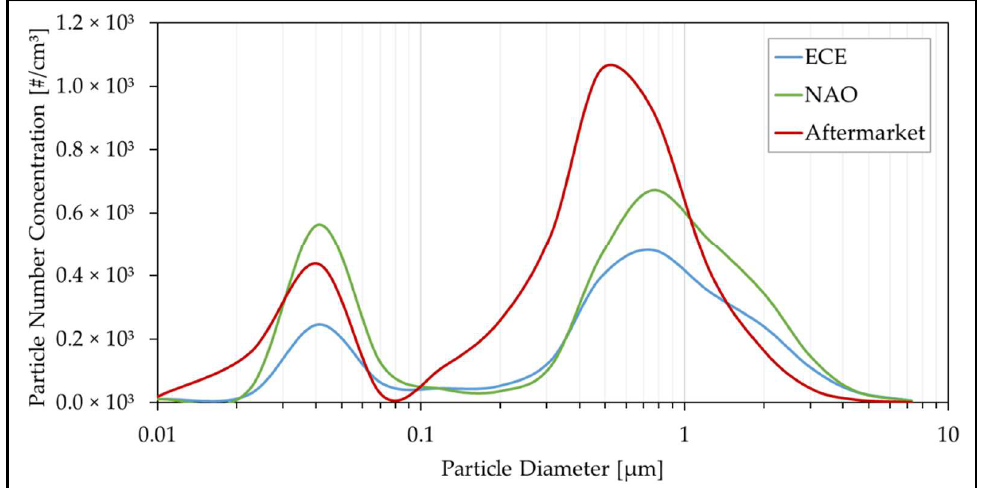
Figure 9. Particle size distribution (TPN measured with ELPI) of the secondary emission during WLTP Brake Cycle Trip 10 constant 112 km/h cruising.